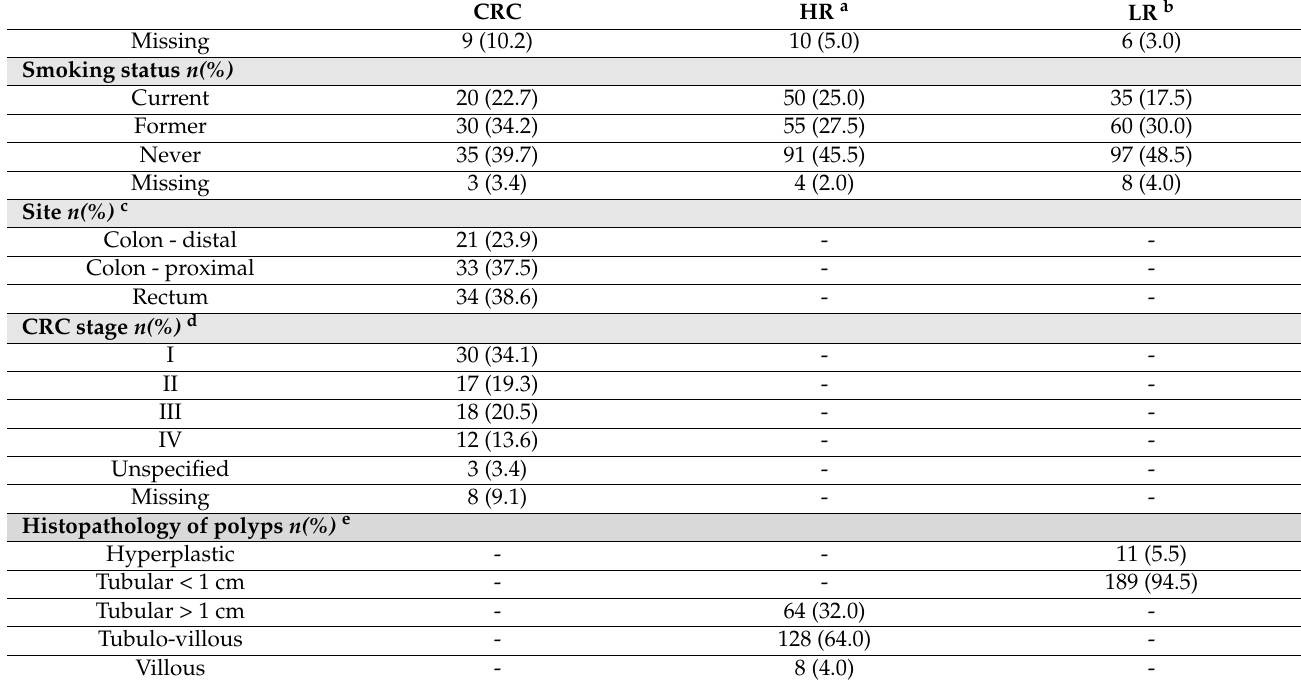
Table 1. Demographics and clinical characteristics of the study population ( n = 488).